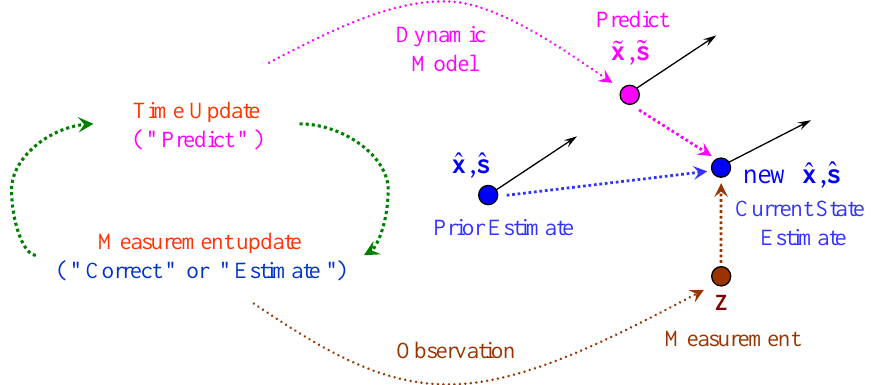
Figure 1. The prediction and correction phase of tracking systems. As shown in (10), in update state, the value of KG is calculated by using the error variance value in prediction state and the error variance value in the measurement. The KG is the weight of the measurement and the weight of the previous estimate. The covariance matrix of the noise of measured value is represented by R (the covariance matrix of v , v : measurement noise). ˆx k is the state estimate matrix, and K k is the weight